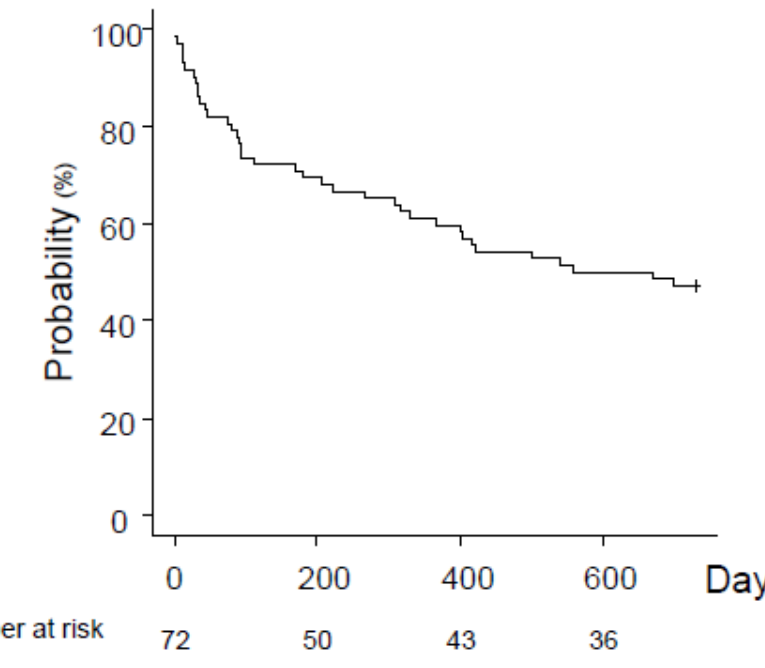
Figure 2. 2-year survival after sepsis. Table 1. Characteristics, treatment of sepsis, outcome, PICS assessments of the patients in the study. Table 2. PICS assessments of the patients in the